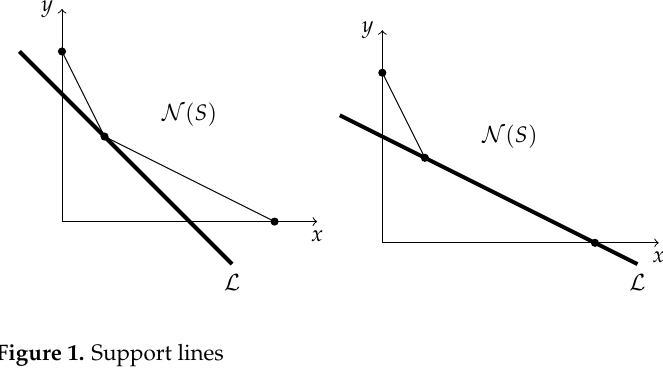
Figure 1. Support